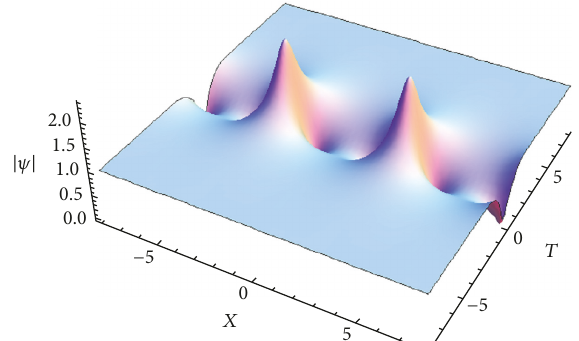
Figure 12: Spatial structure of the module of solution (81) with 𝑘 = 1 .